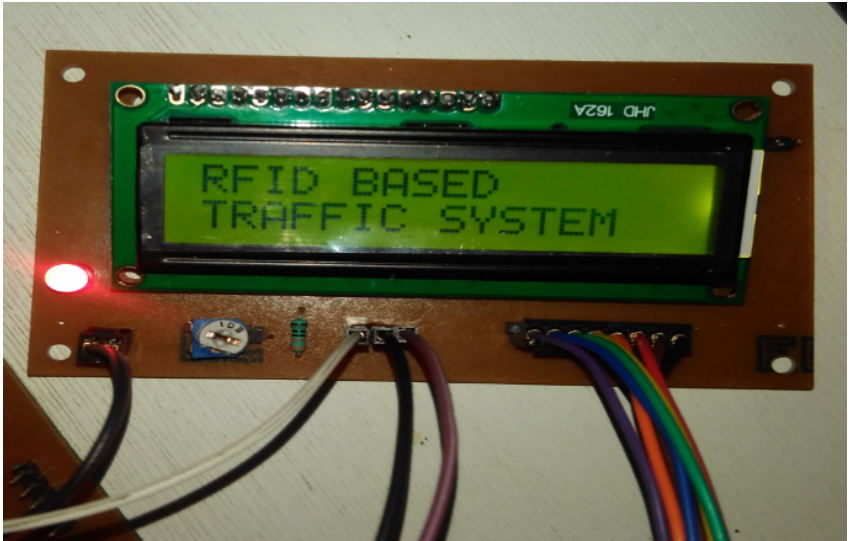
Fig. 7. RFID Based Traffic System